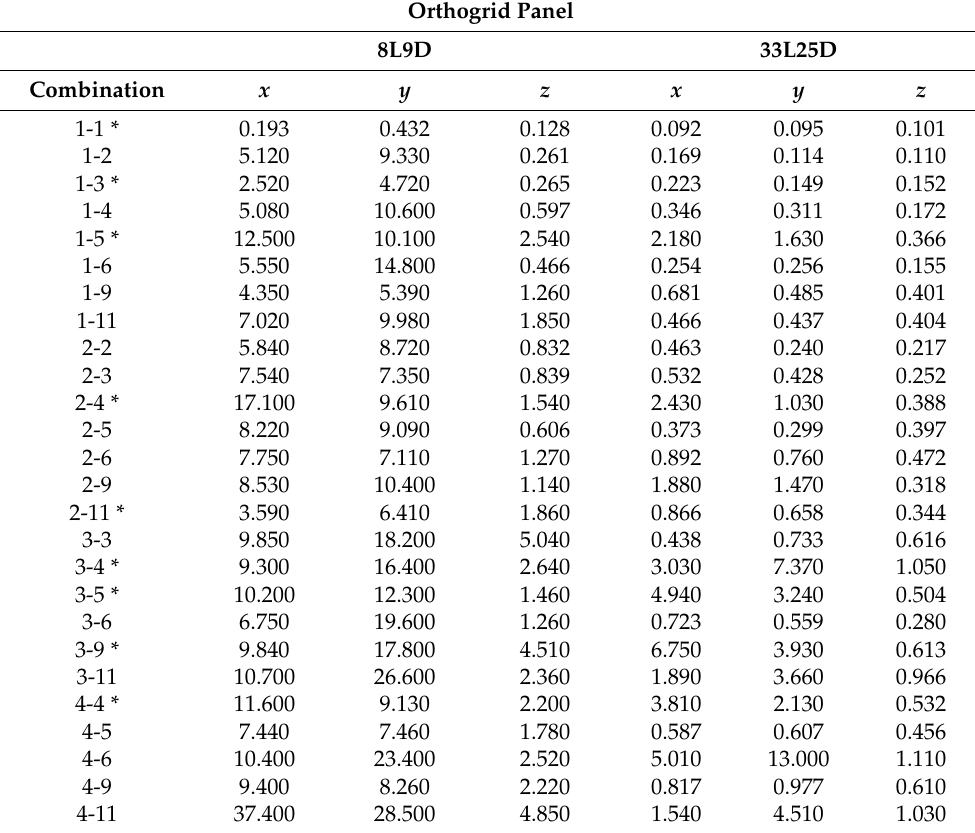
Table 6. Maximum representation errors (in %) of the dual data by the two bases.